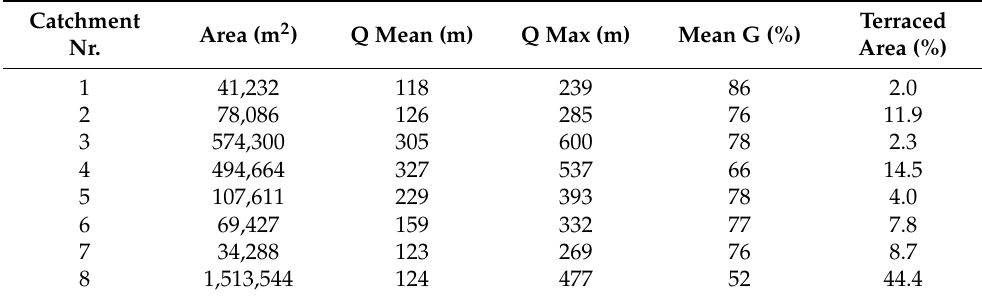
Table 3. Main features of the small catchments and percentage of terraced areas: Q Mean = mean altitude; Q Max = maximum altitude; Mean G = mean slope gradient.